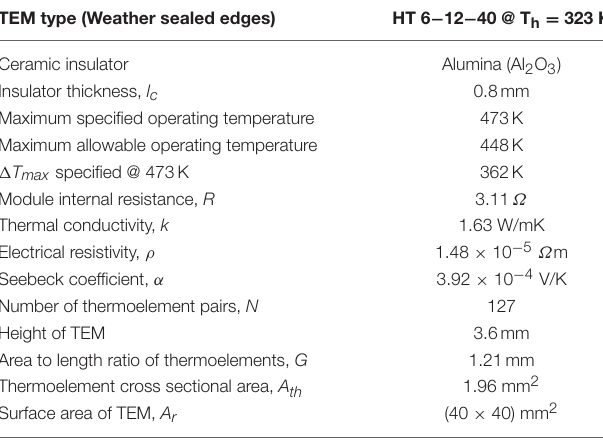
TABLE 3 | The physical properties of the Melcor TEM used for the validation. TEM type (Weather sealed